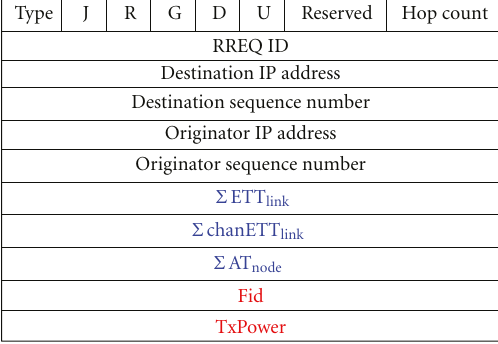
Figure 3: The format of RREQ packet.